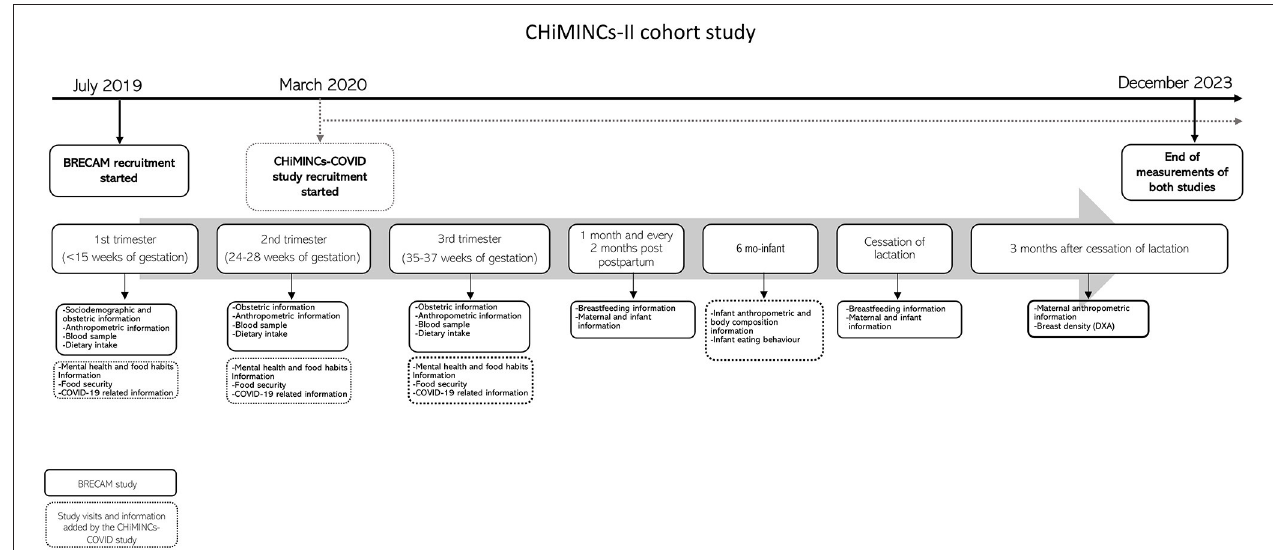
FIGURE 1 | Timeline of the CHiMINCs-II